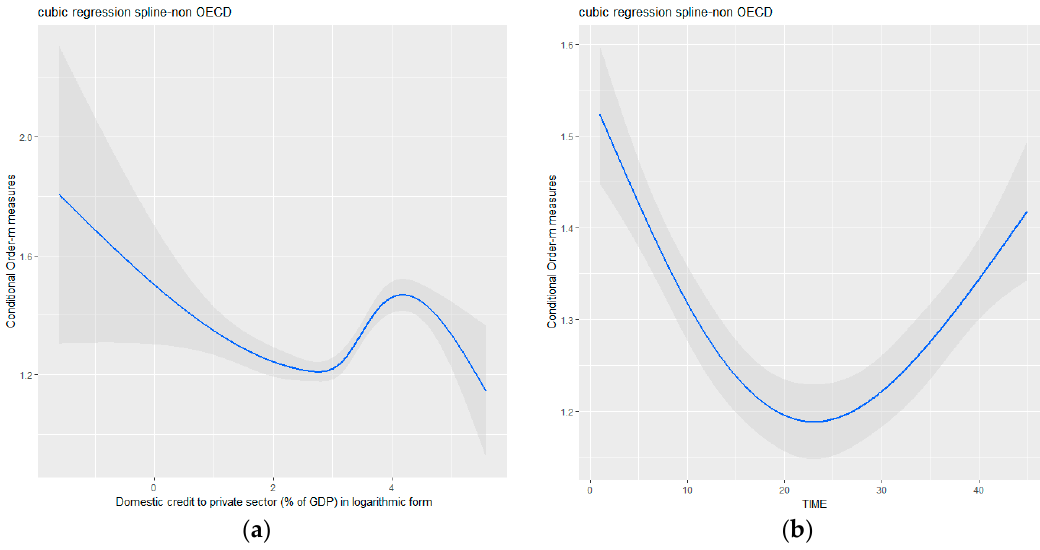
Figure 5. The effect of domestic credit and time on countries’ production efficiencies (non-OECD countries): ( a ) The effect of domestic credit to the private sector (non-OECD countries); ( b ) the effect of time (non-OECD countries).